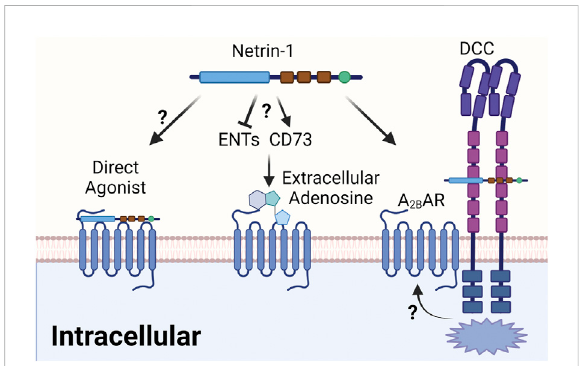
FIGURE 6 Proposed mechanism of the netrin-1/Adora2b linkage. The interaction between netrin-1 and Adora2b could have several different mechanisms. Firstly, the issue of a direct interaction between netrin-1 and the Adora2b is still controversial, although previous study has indicated netrin-1 as direct agonist. Alternatively, netrin-1 could function to enhance extracellular adenosine levels, and thereby promote anti-in fl ammatory signalingpathwaysthatareunderthecontroloftheAdora2b.Such mechanisms could potentially involve increases in extracellular adenosine generation by activation of CD73 or inhibition of extracellular adenosine update via ENTs. An additional alternative of how netrin-1 signaling could enhance Adora2b signaling could involve an interaction of netrin-1 with a classic netrin-1 receptor, such as the DCC, which was indicated in previous studies. This could argue for a signaling pathway where netrin-1 binds to DCC and an interaction between DCC and the Adora2b promotes intracellular signaling cascades that are in line with Adora2b